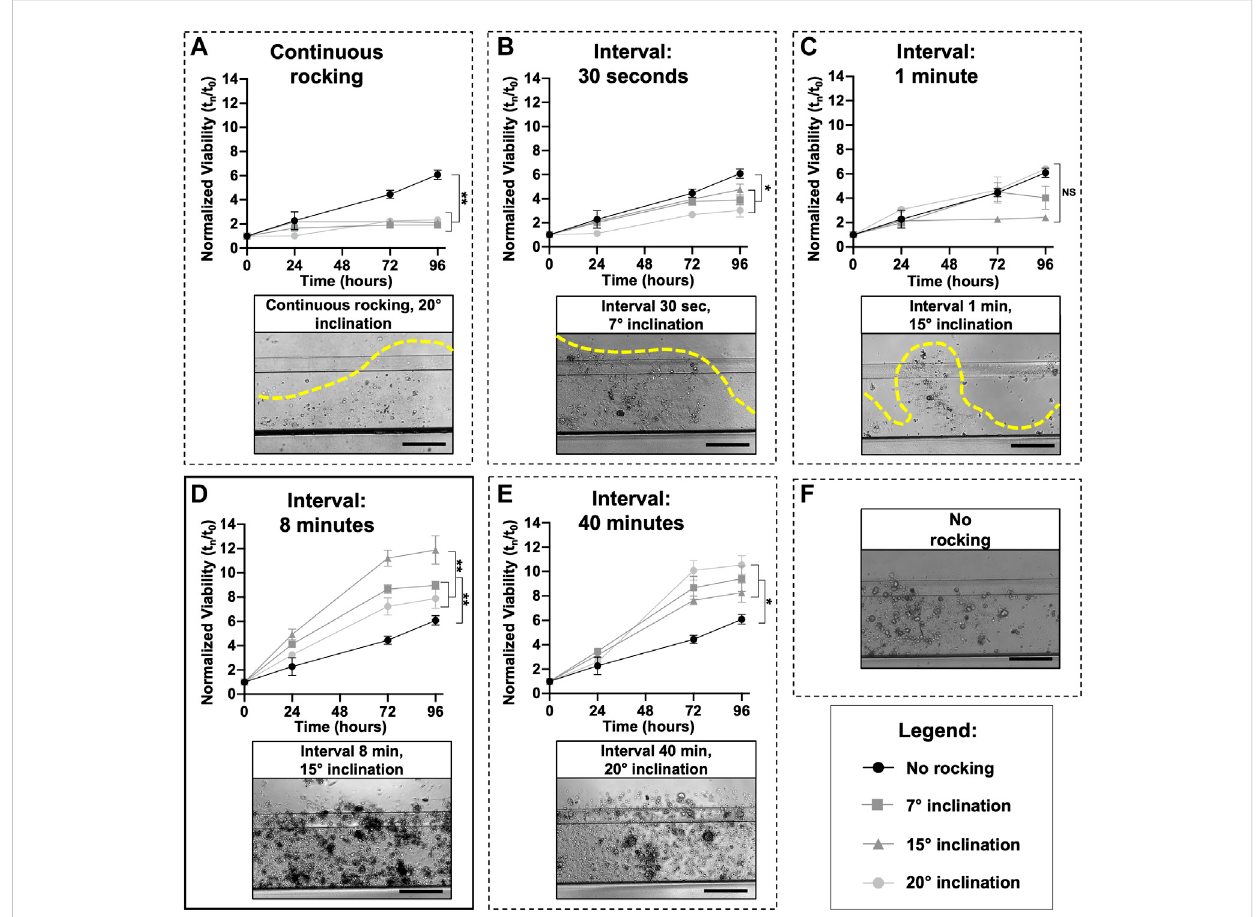
FIGURE 3 Micro fl uidic setup: The perfusion fl ow of the medium inside the OrganoFlow can be modulated by adjusting the interval of rocking (switching sides every 5 s to 999 min) and rocking angles (0 ° to +25 ° ); to fi nd the best growth conditions, different micro fl uidic setups were tested. For each rocking condition,thegrowthcurvesoforganoidsdividedbythreedifferenttiltingangles(7 ° ,15 ° ,and20 ° )andcomparedwiththenorockingcondition(inblack)is reported;thesamewasdoneforall theconditions. Cellviability(mean±SD)wasmeasuredusingthePrestoBlueHSAssayfor 96 h.Arepresentative bright- fi eldimageoforganoidsculturedindifferentconditionsisalsoshown.Inparticular,image (D) correspondstothecondition(tiltingangleof15 ° and interval of rocking every 8 min) in which the organoids have the highest growth rate, while (E) corresponds to the interval of rocking of 40 min. Images (A – C) correspond to continuous rocking and intervals of rocking of 30 s and 1 min, respectively; all these conditions generate a very high fl ow that destroys the ECM. Image (F) corresponds to a no-rocking condition. The p -values were calculated using two-way ANOVA, * p ≤ 0.05, ** p ≤ 0.01. Scale bar 500 μ